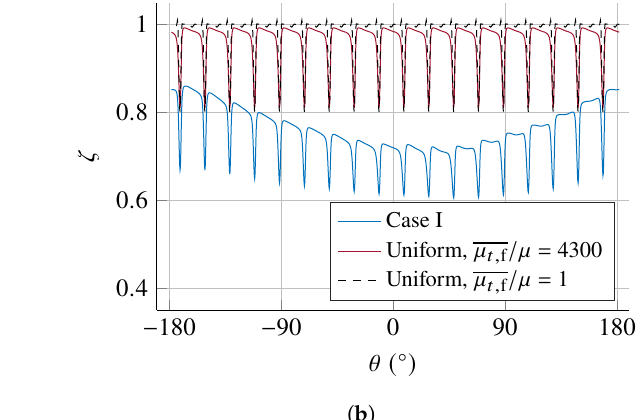
( s s ∞ ) / R ] at the rotor downstream − −